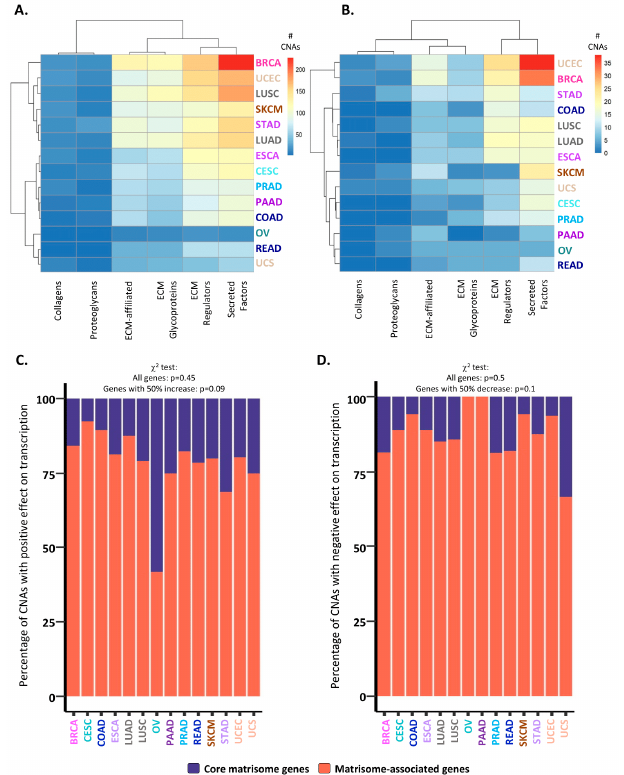
Figure 2. Consequences of CNAs on matrisome gene expression levels. ( A ) Number of total CNAs identified in matrisome genes per cancer type and matrisome category. ( B ) Number of CNAs with significant effects (i.e., resulting in at least a 50% increase or decrease in expression level vs. patients with no CNAs) on matrisome gene transcription per cancer type and matrisome category. In ( A ) and ( B ), bars represent the number of genes whose expression is affected by CNAs per tumor, from lowest (blue) to highest (red) values. ( C , D ) Bar charts represent the percentage of CNAs with a significant ( > 50% higher or lower gene expression than in patients with no CNA) positive ( C ) or negative ( D ) impact on core matrisome (purple) or matrisome-associated (coral) gene transcription.